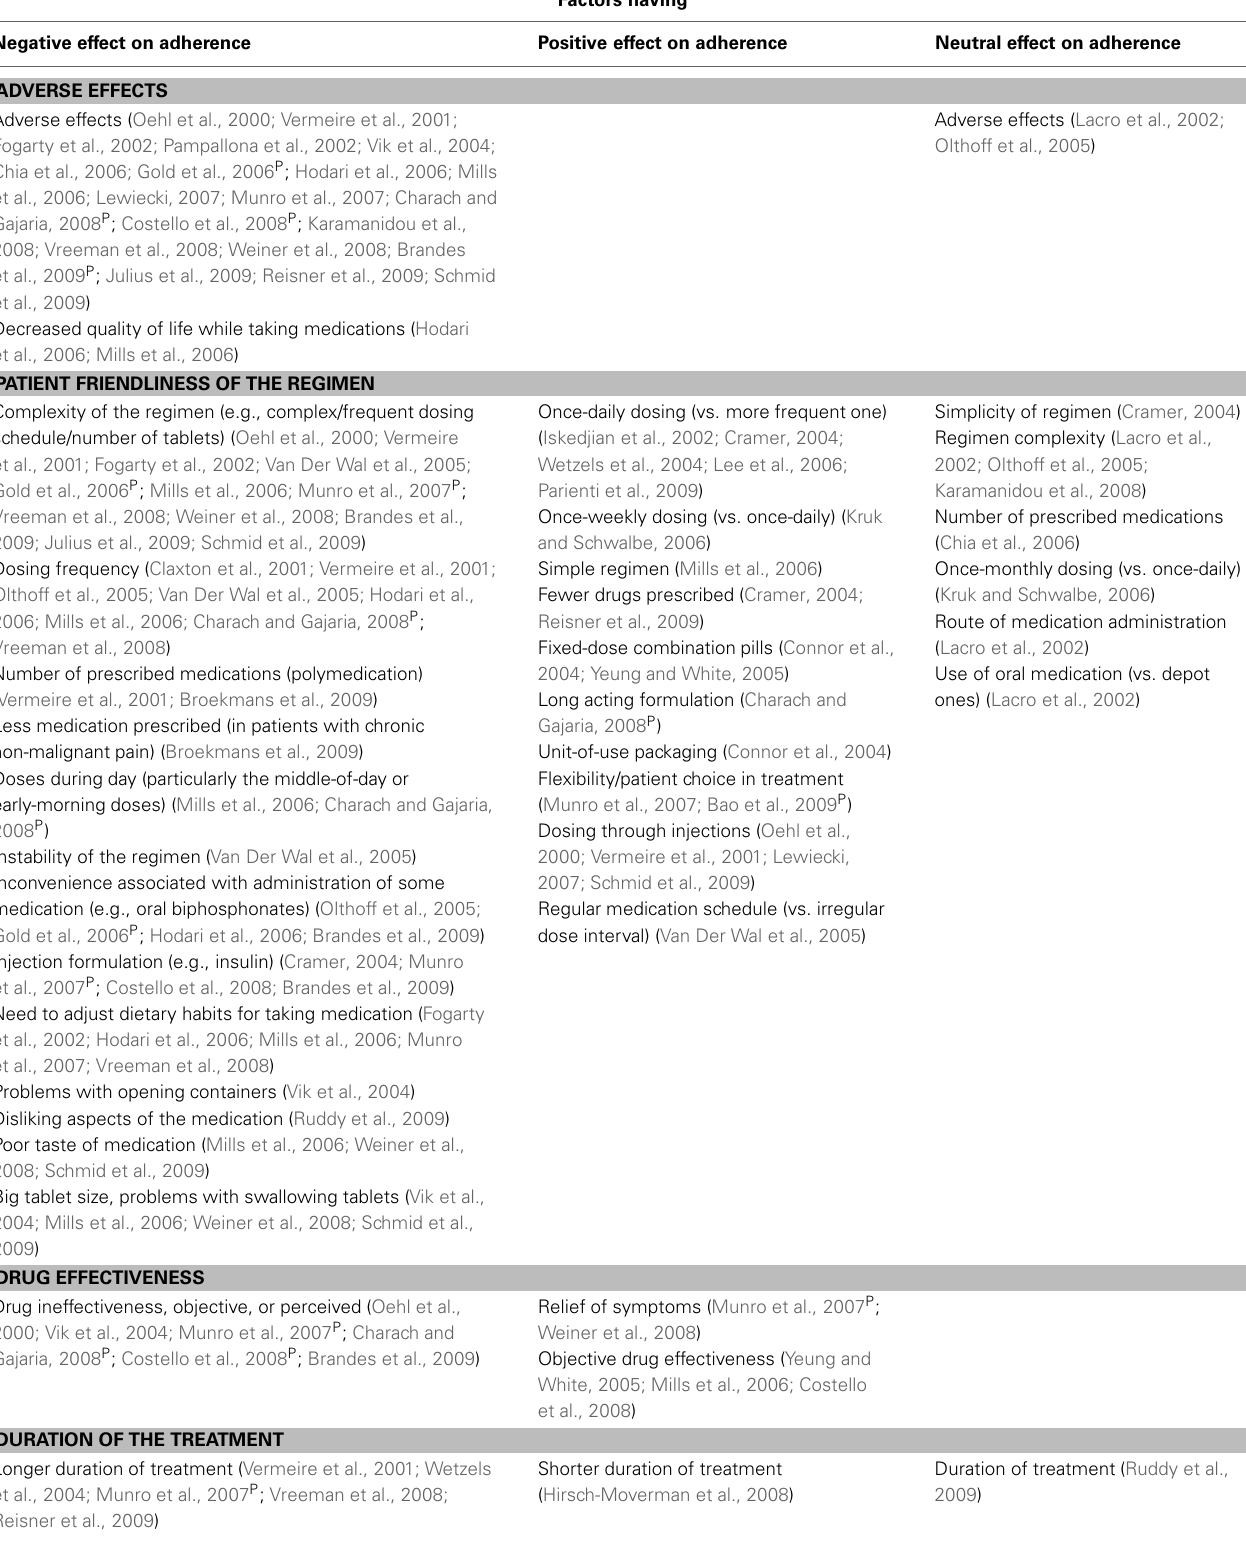
Table 6 | Therapy-related factors affecting